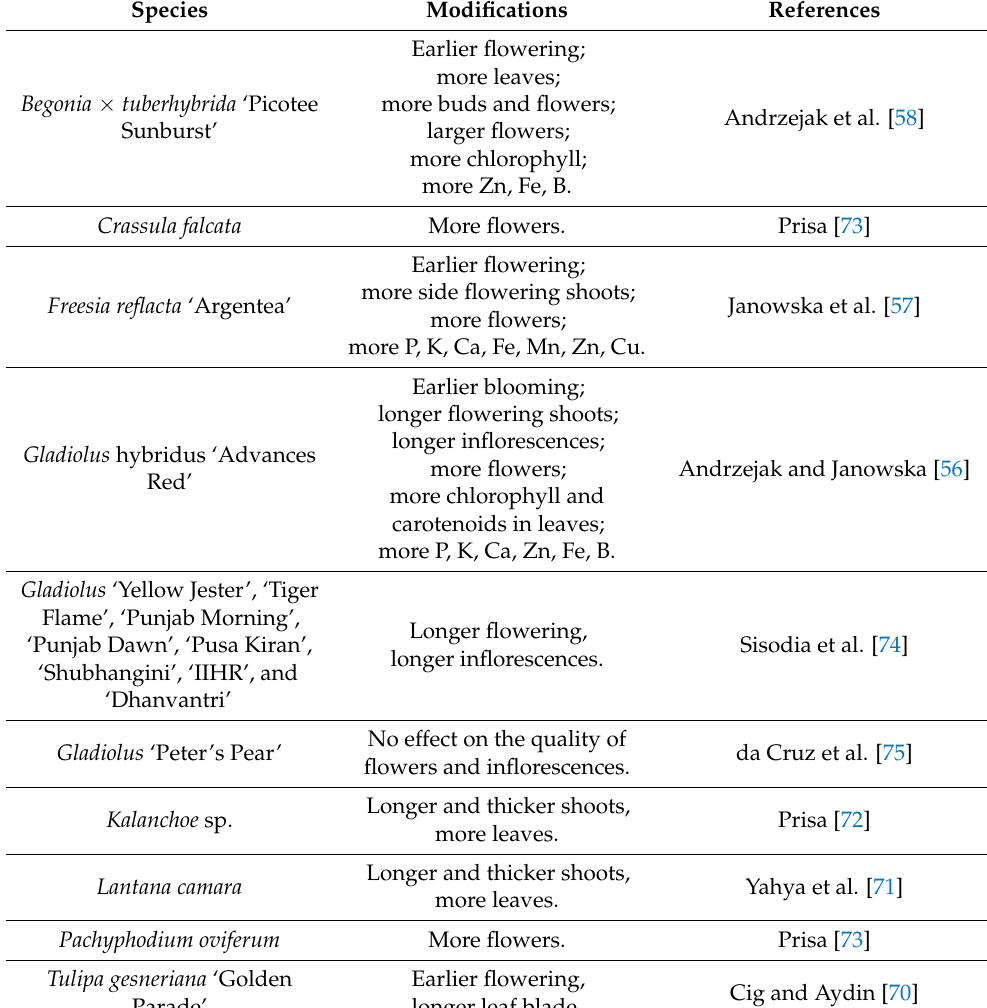
Table 2. Effect of Trichoderma spp. on ornamental